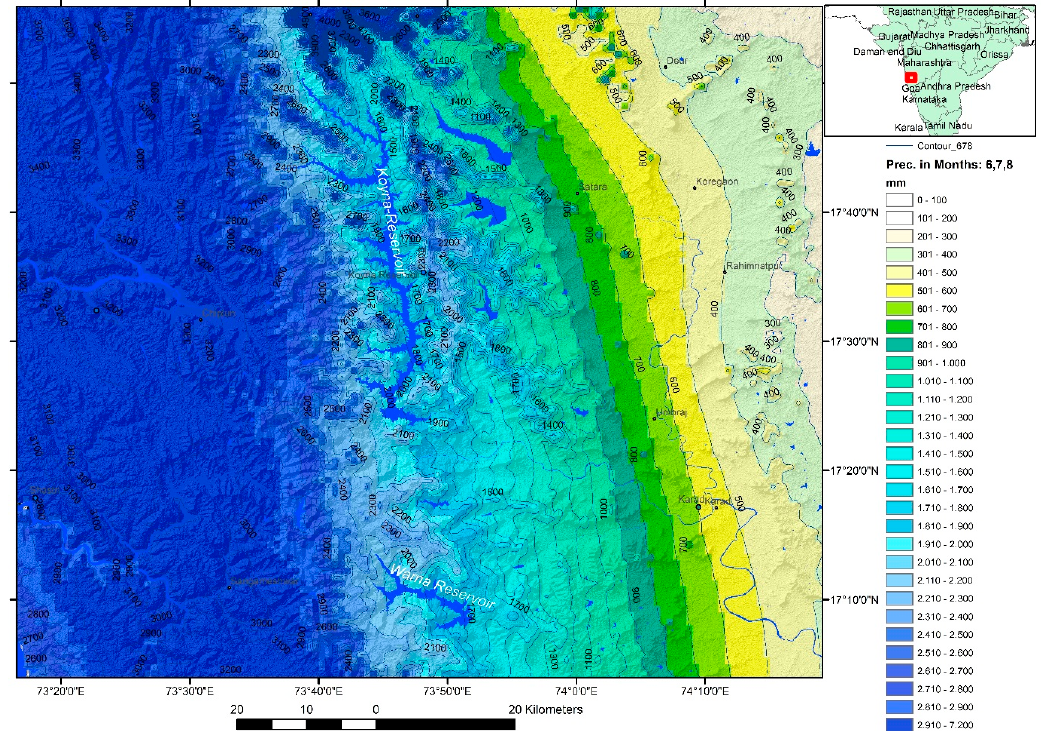
Figure 2. Precipitation concentration from June–August, average monthly precipitation (mm) from ~1950 to 2000 (data: WorldClim) [19].